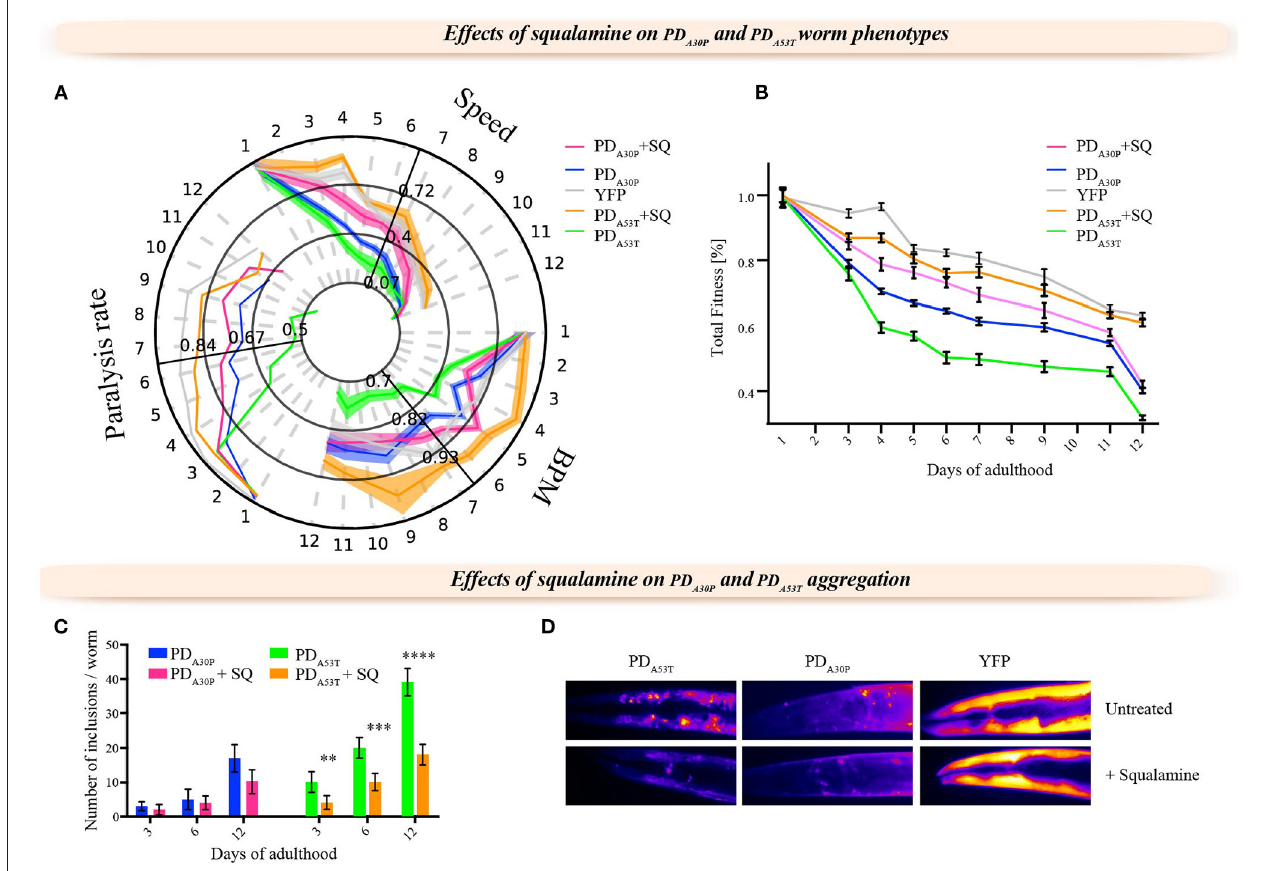
FIGURE 3 | Effects of squalamine on the formation of α -syn inclusions and the fitness of PD A30P and PD A53T worms. (A) Behavioral time-course map reporting thee rate of body bends, swimming speed and paralysis rate for PD A30P and PD A53T worms exposed to 10 µ M squalamine. (B) Calculation of the total fitness corresponding to the three readouts in (A) ( Perni et al., 2017b, 2018b). The effects of squalamine on control worms were negligible (Perni et al., 2017b), and only a small protective effect could be observed in PD A30P, while strong protective effects were observed in PD A53T worms consistently with the effects on the PD WT worms ( Perni et al., 2017b). Each experiment was carried out in triplicate, and about 1,000 worms were analyzed in each replicate; one representative experiment of the three is shown. (C) Quantification of the number of inclusions in PD A30P and PD A53T worms with or without squalamine; squalamine reduced significantly the number of inclusions in PD A53T worms ** P ≤ 0.01,*** P ≤ 0.001 and **** P ≤ 0.0001. (D) Representative images showing a substantial decrease in the number of α -syn inclusions in the presence of squalamine in PD A53T worms. In order to show the inclusions more clearly, the image focus on only the heads of the worms, although the quantification was carried out using the whole worms. This result is consistent with previous observations for PD WT worms ( Perni et al., 2017b). In the YFP worms, the expression pattern is not significantly affected while in PD A30P worms the number of inclusions appears mildly reduced. All measurements were carried out at day 12 of